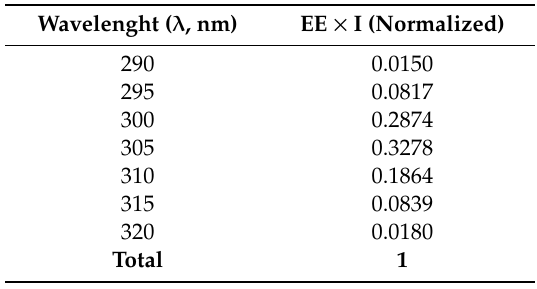
Table 1. Normalized product function used in the calculation of SPF. Values adapted from the work of Sayre and co-workers